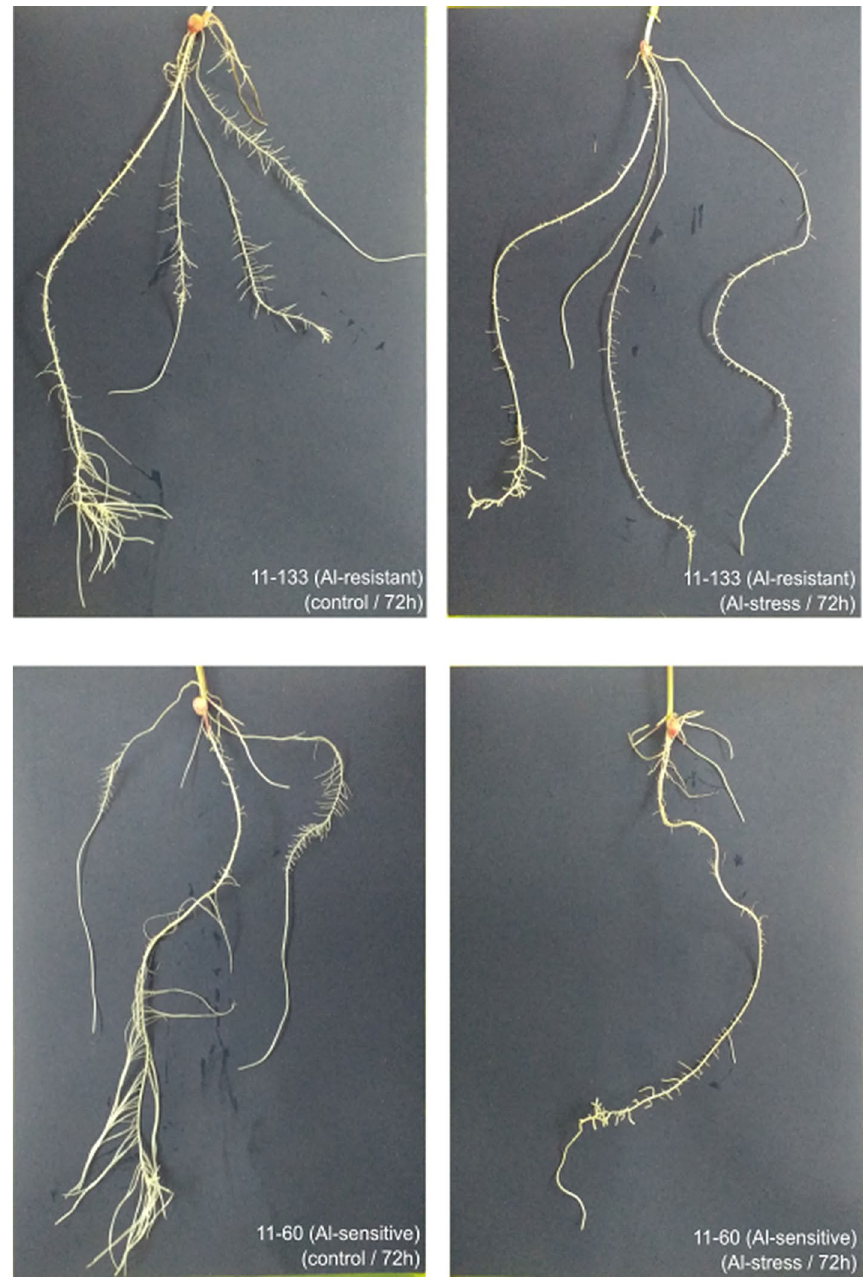
Figure 1. Phenotype of Al-resistant (11–133) and Al-sensitive (11–60) inbred popcorn lines after 72 h in control conditions and Al